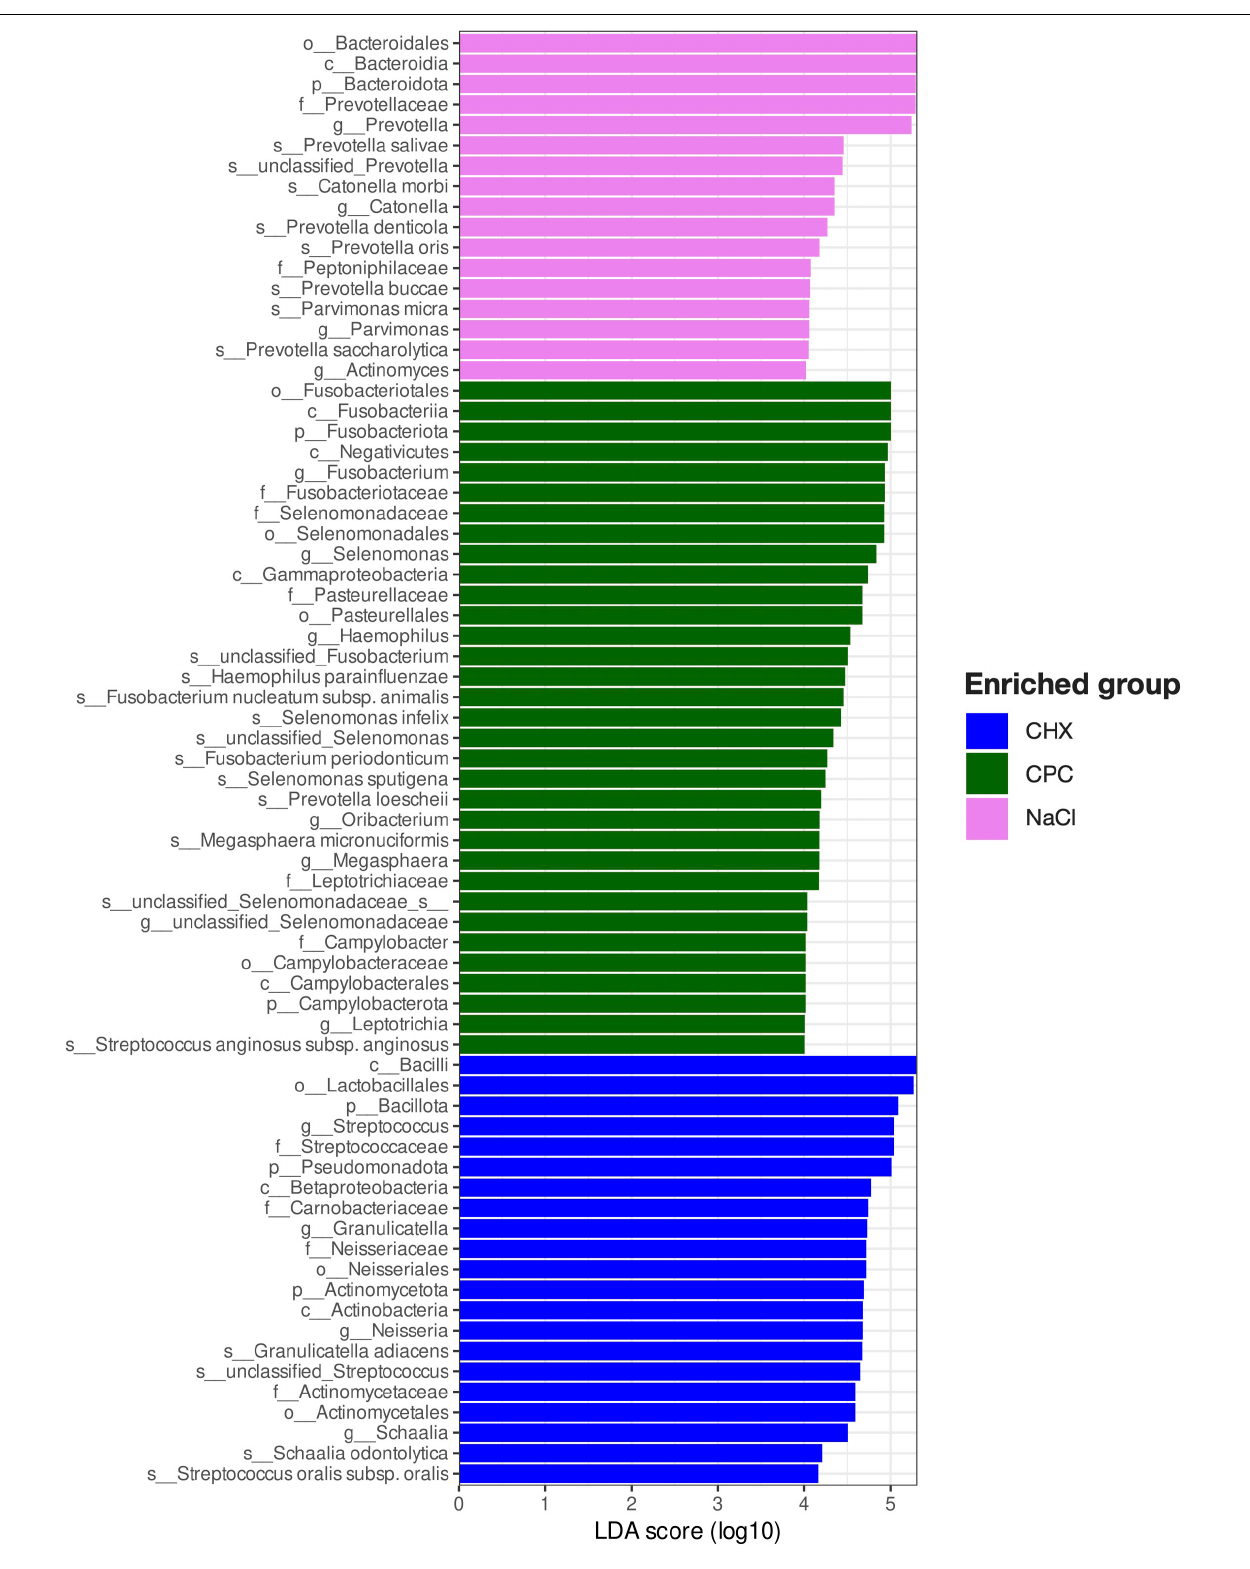
FIGURE 4 | Discriminatory ASVs for biofilms treated with NaCl, CPC, or CHX, respectively, as identified by linear discriminant analysis (LDA) effect size (LEfSe). ASVs exhibiting LDA-score ≥ 4 and adjusted p -values < 0.01 are shown.